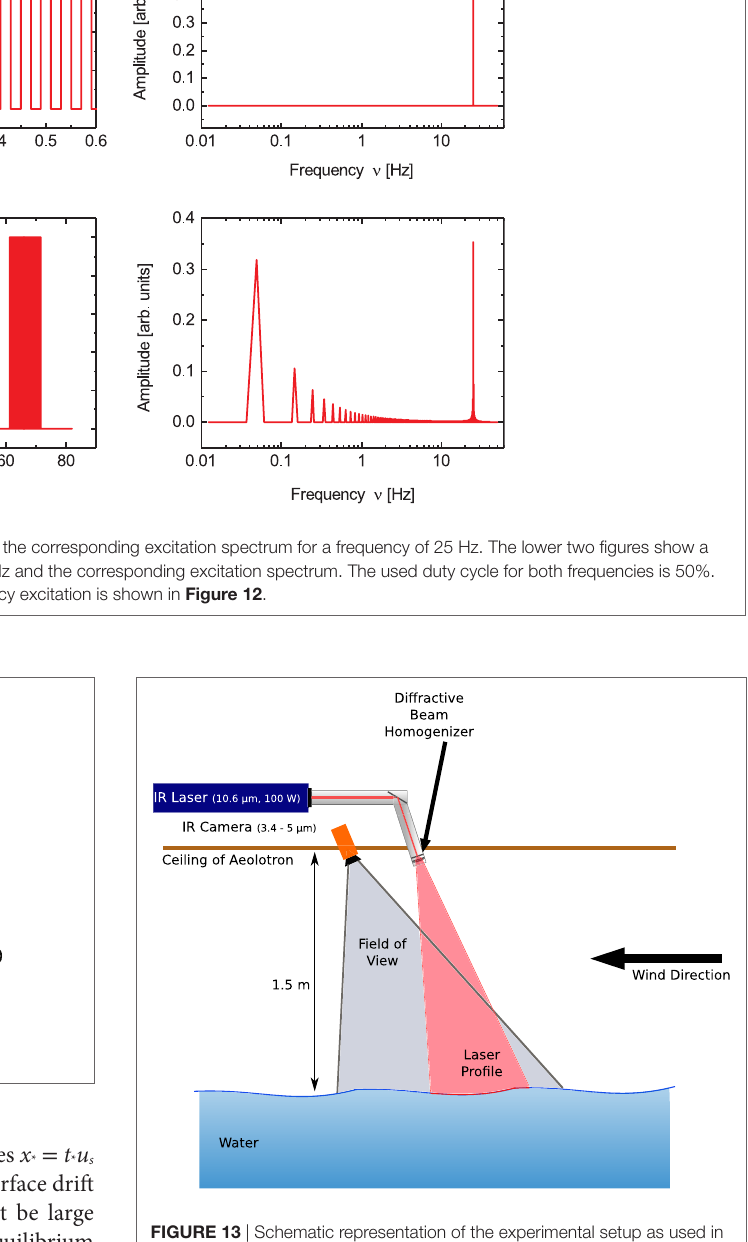
FigURe 13 | Schematic representation of the experimental setup as used in the Heidelberg wind-wave facility Aeolotron. An IR laser is used to heat the water surface, while an IR camera measures the temperature changes at the water surface.